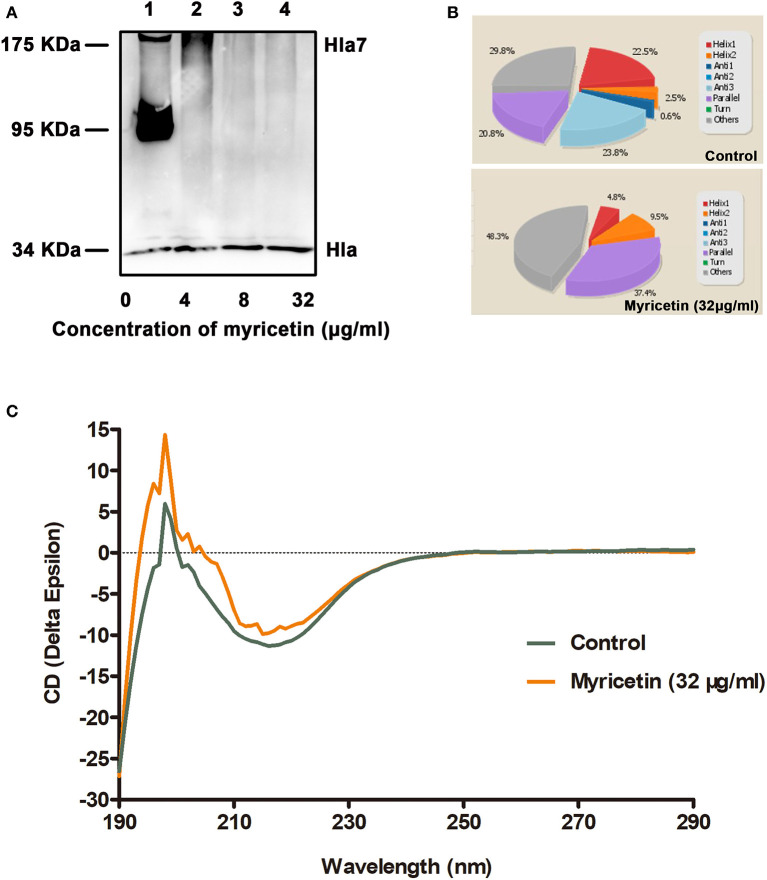
Myricetin interferes with the deoxycholate-induced oligomerization of Hla. (A) The oligomerization of Hla in the presence of various concentrations of myricetin was determined using western blot assay. (B,C) Circular dichroism analysis of Hla in the presence or absence of myricetin. The percentages of α-helix and turn conformations in Hla were both reduced by myricetin. The sample treated with DMSO was used as a control.